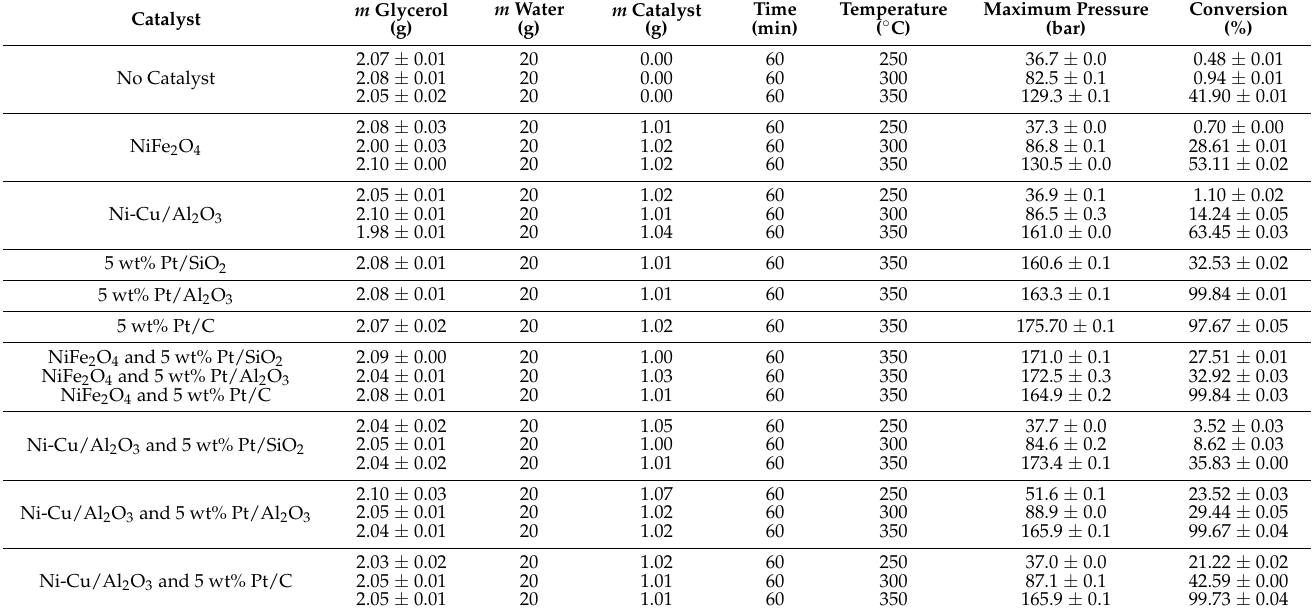
Table 2. Glycerol conversions under various catalytic hydrothermal reforming